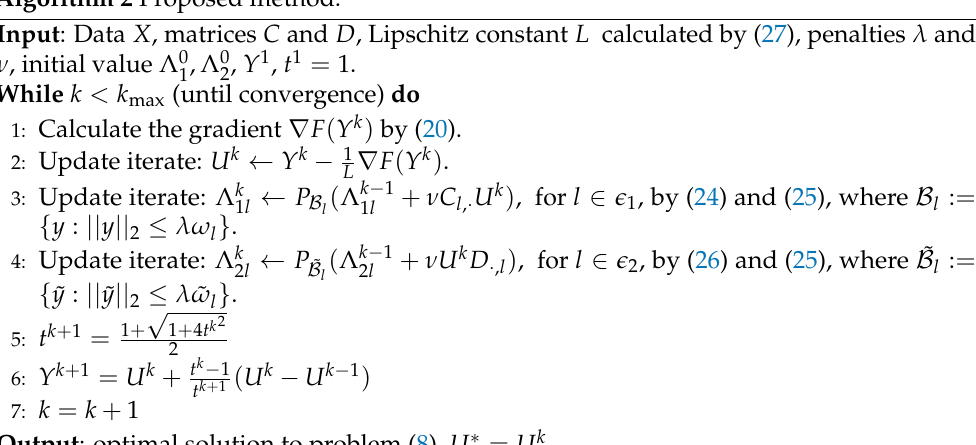
Algorithm 2 Proposed